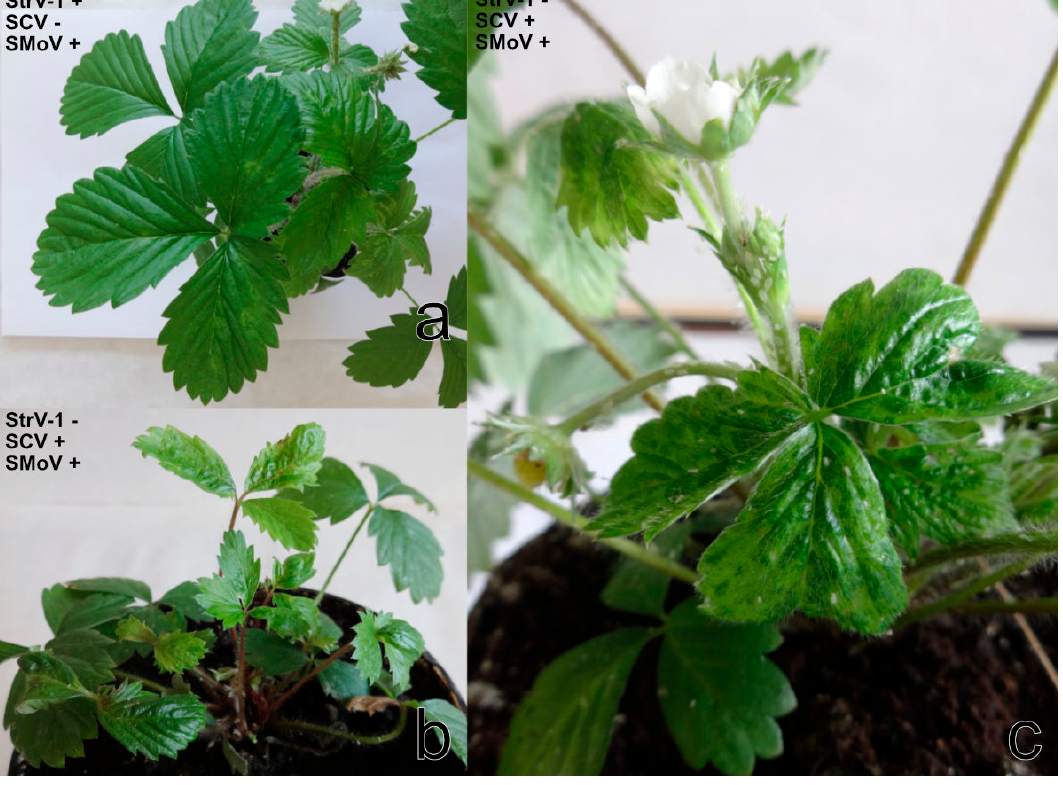
Figure 10. F. vesca ‘Alpine’ after virus transmission by aphid feeding: ( a ) A. malvae revealed chlorotic markings (RT-PCR positive for StrV-1 and SMoV); ( b ) A. solani showed severe dwarfism, leaf malformations, chlorosis and necrosis (SCV and SMoV positive); ( c ) C. fragaefolii exhibited severe mosaic and epinasty (SMoV and SCV positive).